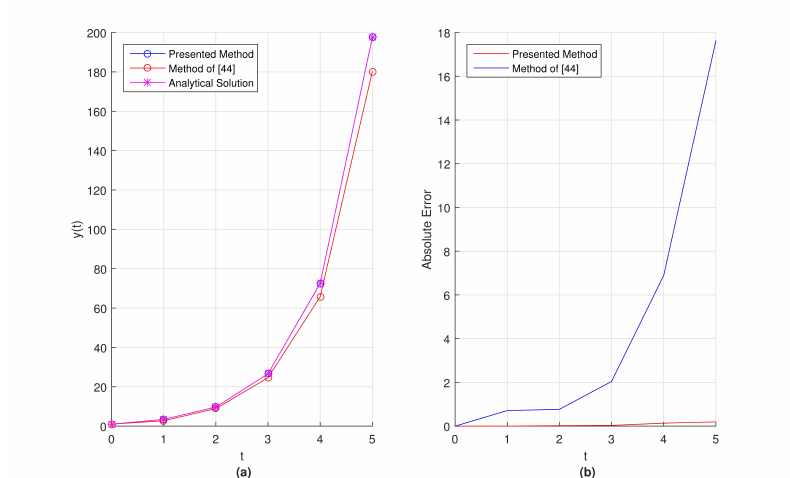
Figure 15. ( a ) The comparison of analytical solution and numerical solutions obtained by the proposed method and the method of [63] with m = 5. ( b ) The behaviour of the absolute errors between the exact solution and numerical solutions obtained by our method and the method given in [63] with m = 5.